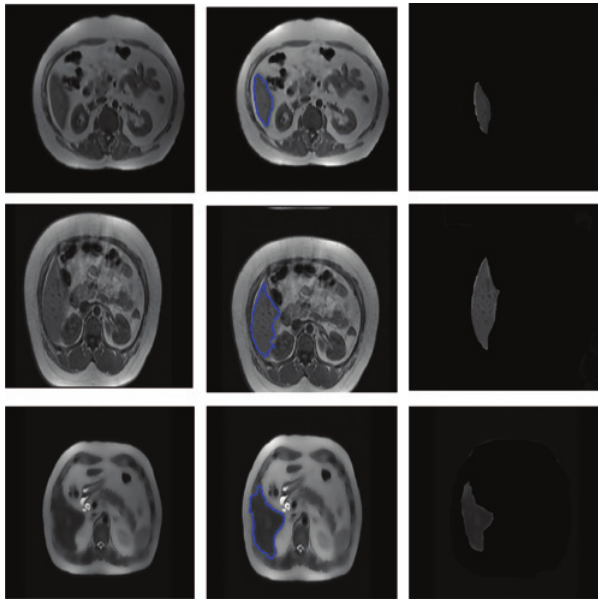
Figure 5: Experimental Results of Proposed Method for MRI Scan Images.